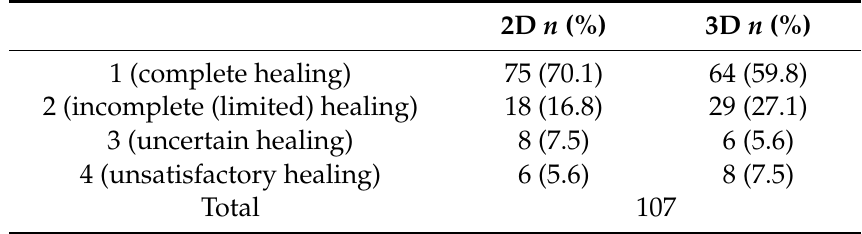
Table 3. A summary of results from 2D and 3D radiographic healing assessment of one-year after the endodontic